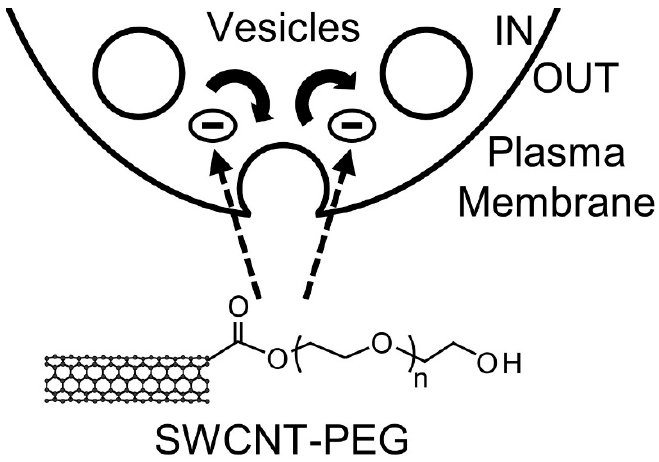
Figure 5. Scheme showing the possible mechanism of action of SWCNT-PEG solute on astrocytes. SWCNT-PEG obstructs vesicular/plasmalemmal recycling in astrocytes by inhibiting ( - ) both the endocytic and exocytotic pathways.